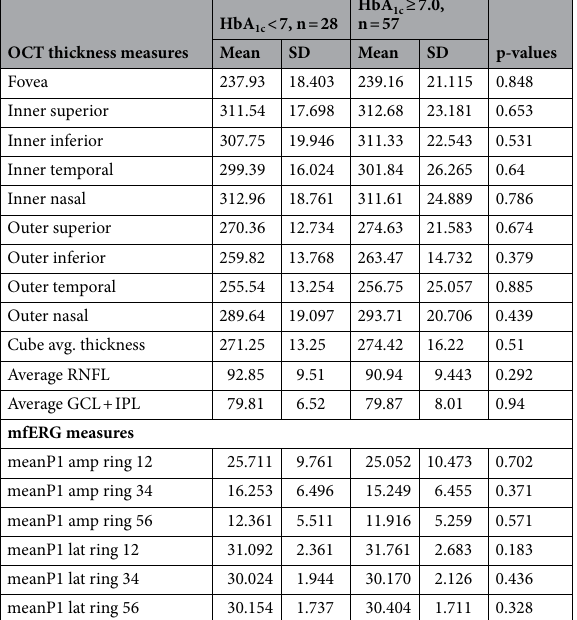
Diabetes duration HbA 1c Correlation between mfERG, duration, HbA 1c Correlation coefficient p-values Correlation coefficient p-values meanP1 amp ring 12 − 0.247